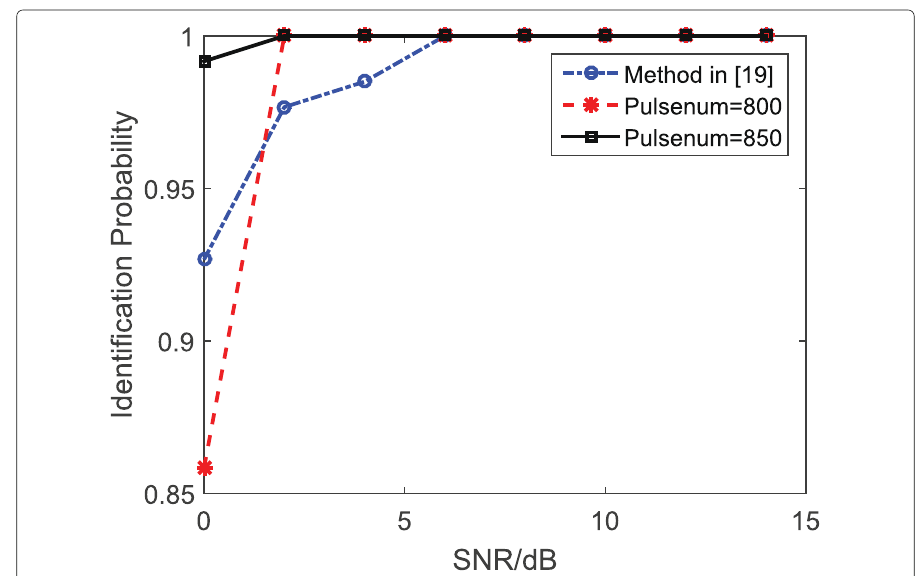
Fig. 8 The identification probabilities of the proposed method under different pulse numbers and the method in [19]